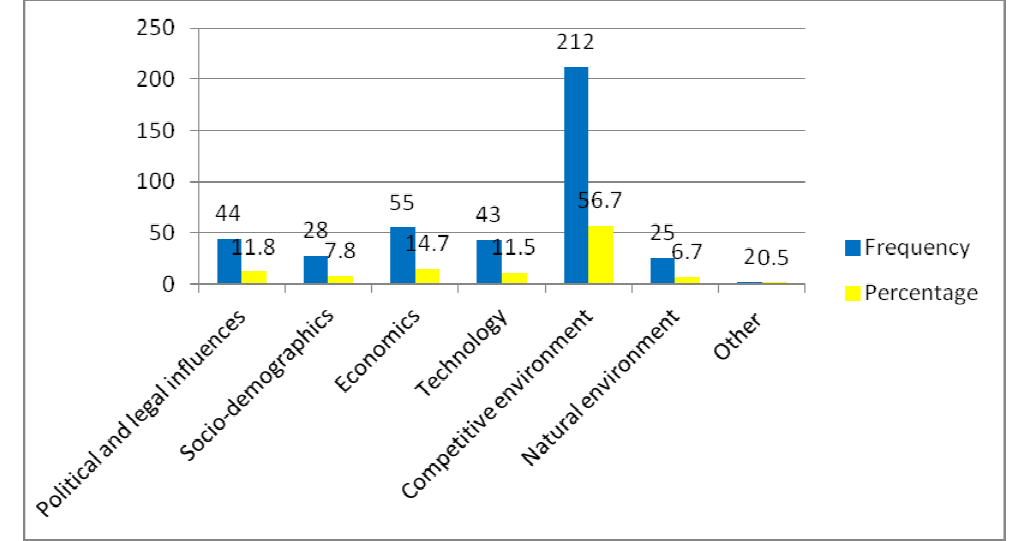
Figure 4: External factors influencing respondents’ marketing activities Perceived Importance of marketing